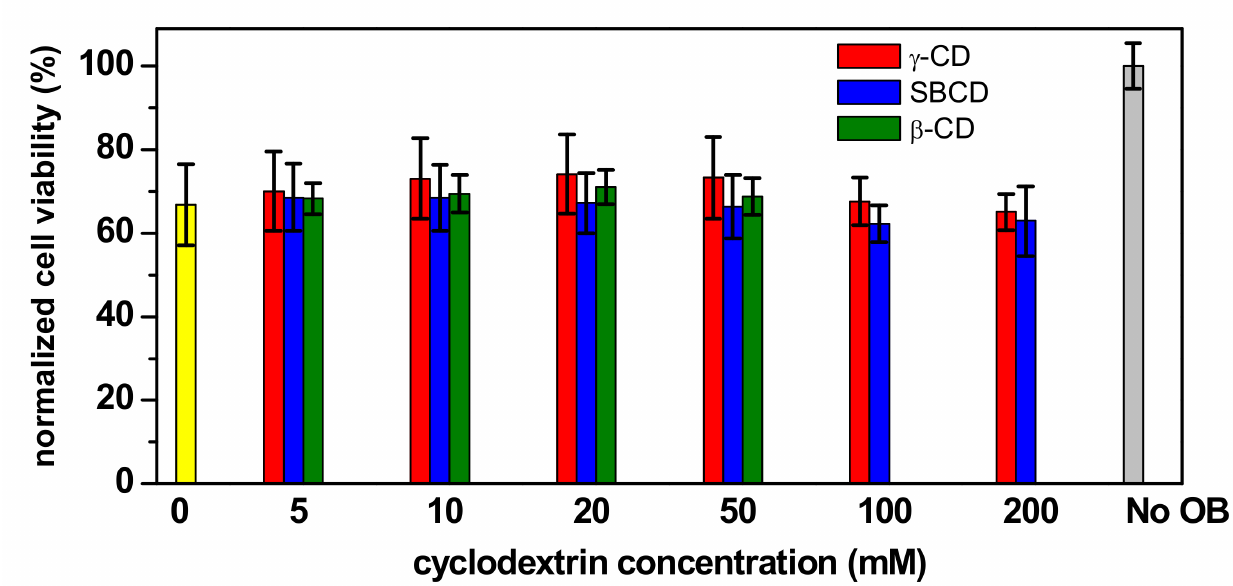
Figure 9. Normalized cell viability of Neuro-2a cells pre-treated with 0.4 mM ouabain (OB) in the absence ( yellow ) and in the presence of γ -CD ( red ), SBCD ( blue ) and β -CD ( green ) at different concentrations. The control in absence of OB is the grey